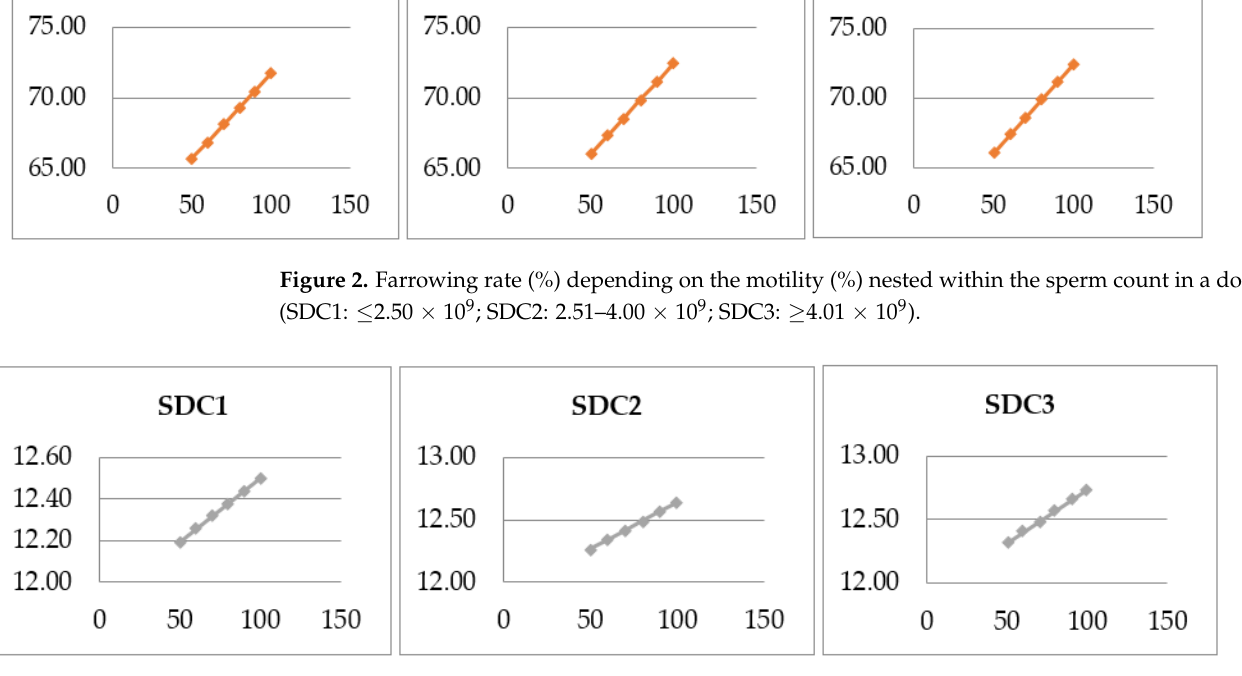
Figure 3. Litter size depending on the motility (%) nested within the sperm count in a dose (SDC1: ≤ 2.50 × 10 9 ; SDC2: 2.51–4.00 × 10 9 ; SDC3: ≥ 4.01 × 10 9 ).